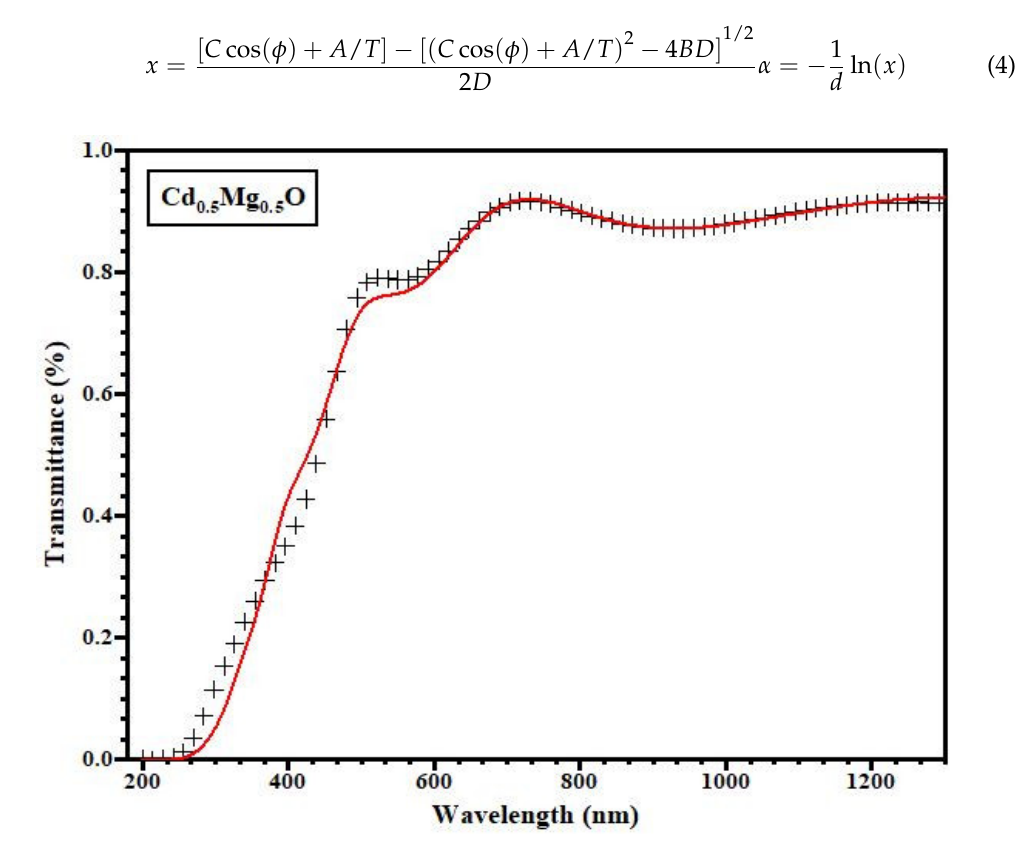
Figure 5. Transmittance of Cd 0.5 Mg 0.5 O thin film along with fitted